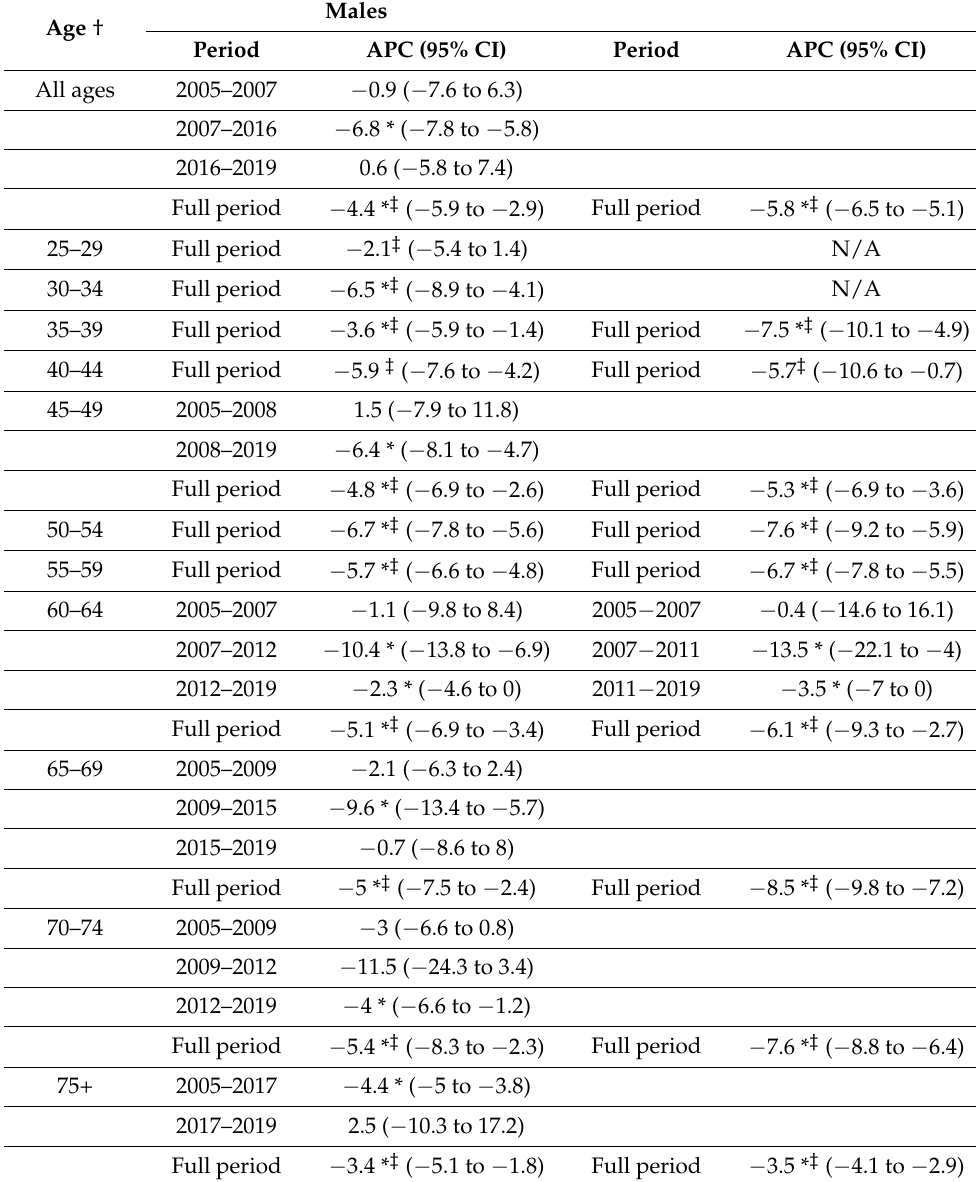
Table 2. Joinpoint analysis: trends * in age-specific mortality rates from acute coronary syndrome (per 100,000 persons) for males and females in Serbia,